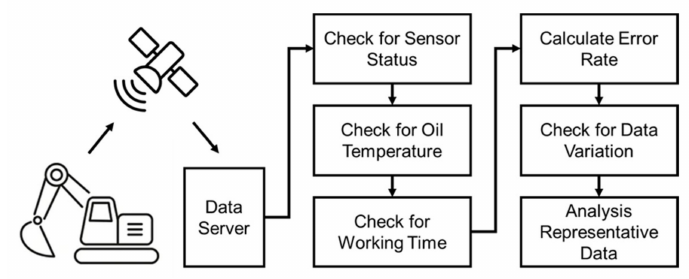
Figure 11. Oil sensor signal data analysis